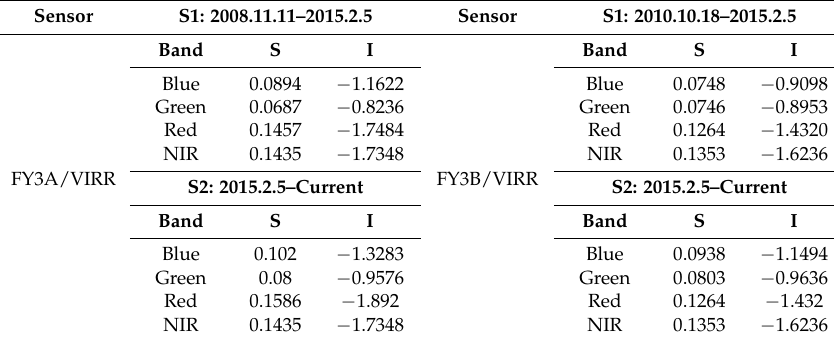
Table 5. The calibration coefficients of VIRRs.